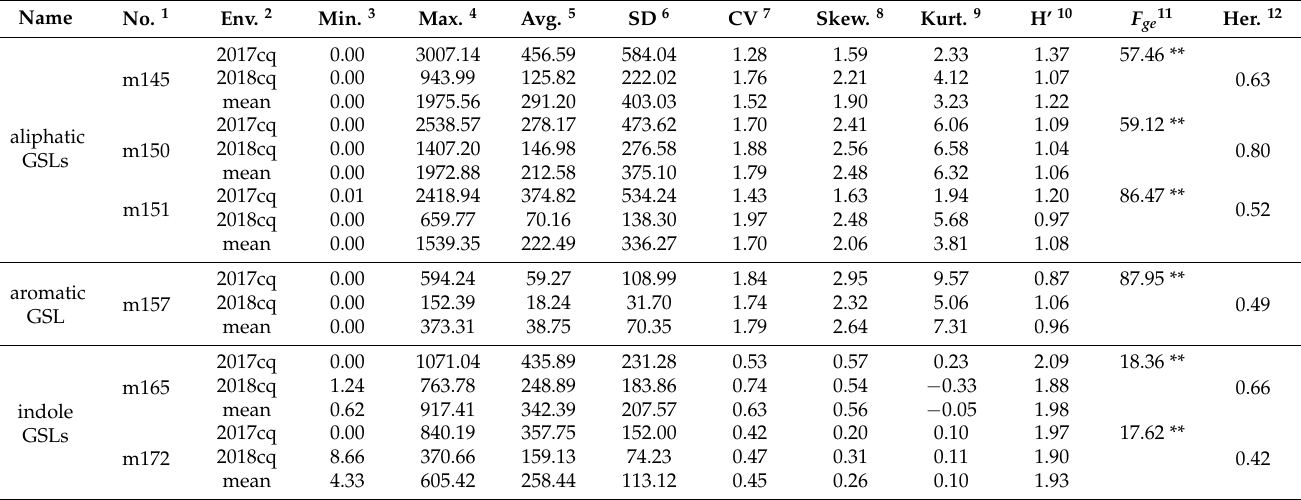
Table 1. Phenotypic variations for six glucosinolate metabolite contents in an association panel of B. napus .